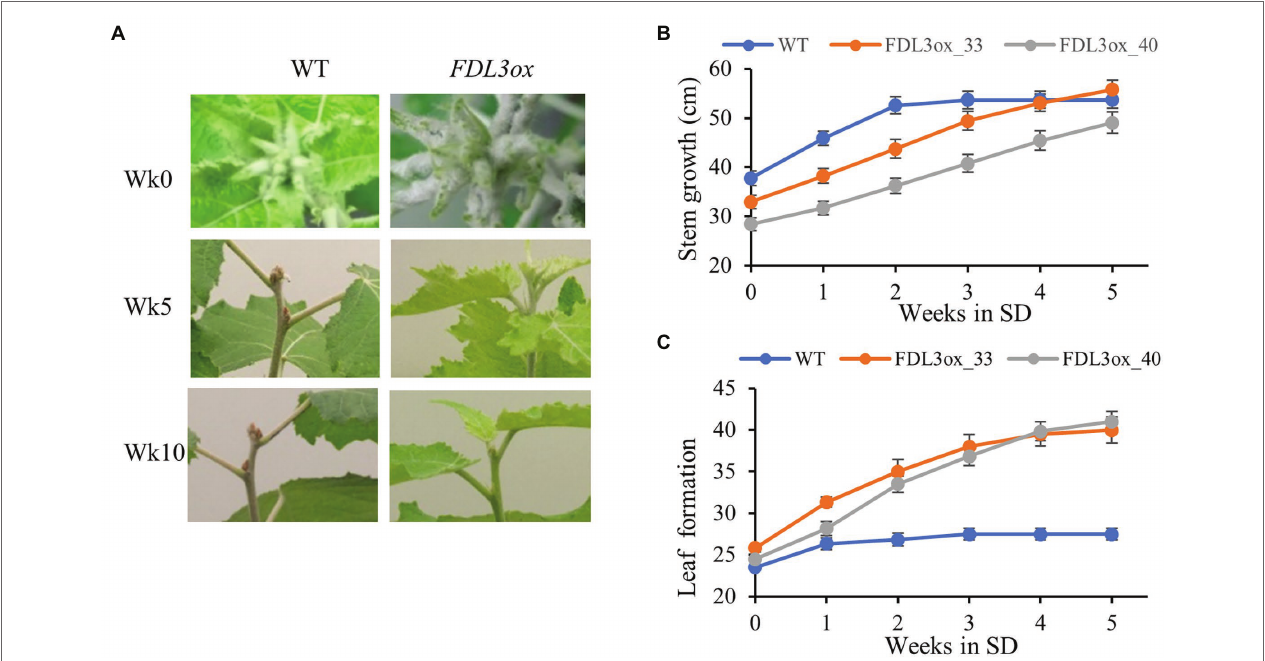
FIGURE 6 | Overexpression of FDL3 delays growth cessation and bud set in short days. Plants of WT and two FDL3ox events (33 and 40) were grown in long days for 2 months before exposure to SDs. (A) Apical bud development of FDL3ox plants compared to WT after 5 and 10 weeks in SD (Week 5 and Week 10). In Week 5, WT plants had formed buds. In contrast, FDL3ox plants maintained actively growing apex. By Week 10, FDL3ox plants formed buds. (B,C) Cumulative stem growth (B) and leaf formation (C) were measured weekly during the first 5 weeks in SDs. (B) Plant height and (C) leaf numbers are means ± SE ( n =